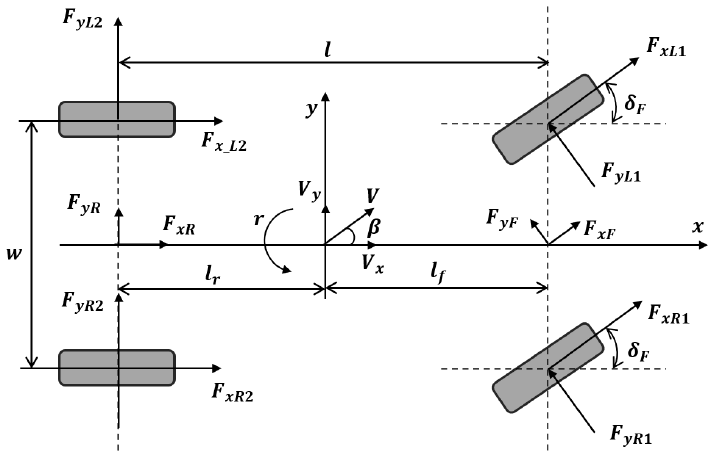
Figure 2. Seven-degrees-of-freedom vehicle